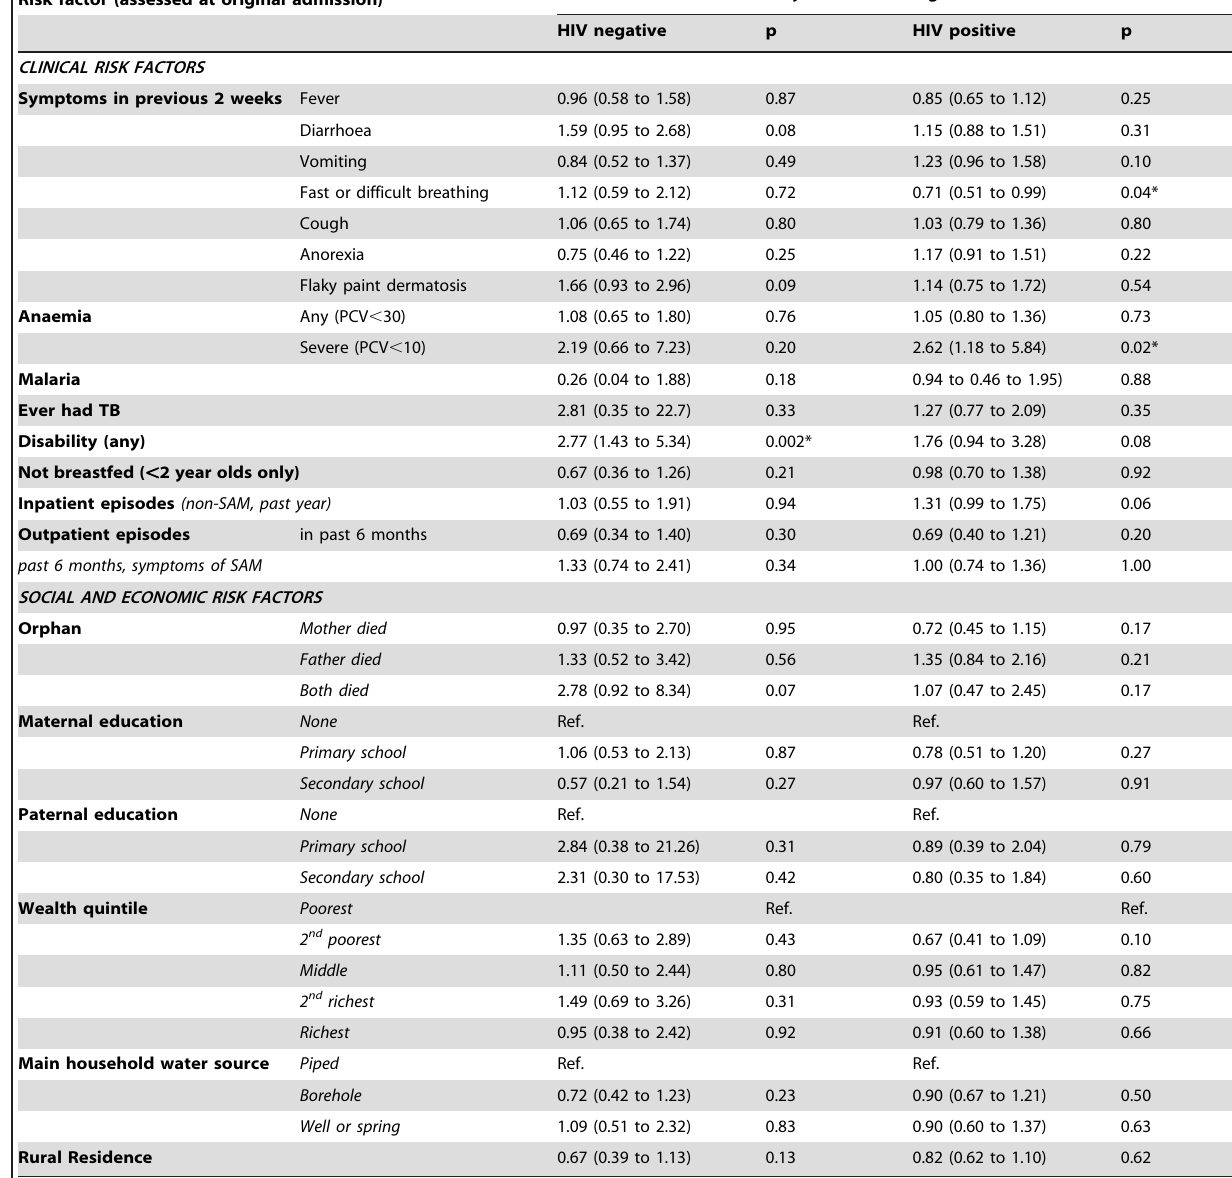
Risk factor (assessed at original admission) Hazard ratio for all mortality (short and long